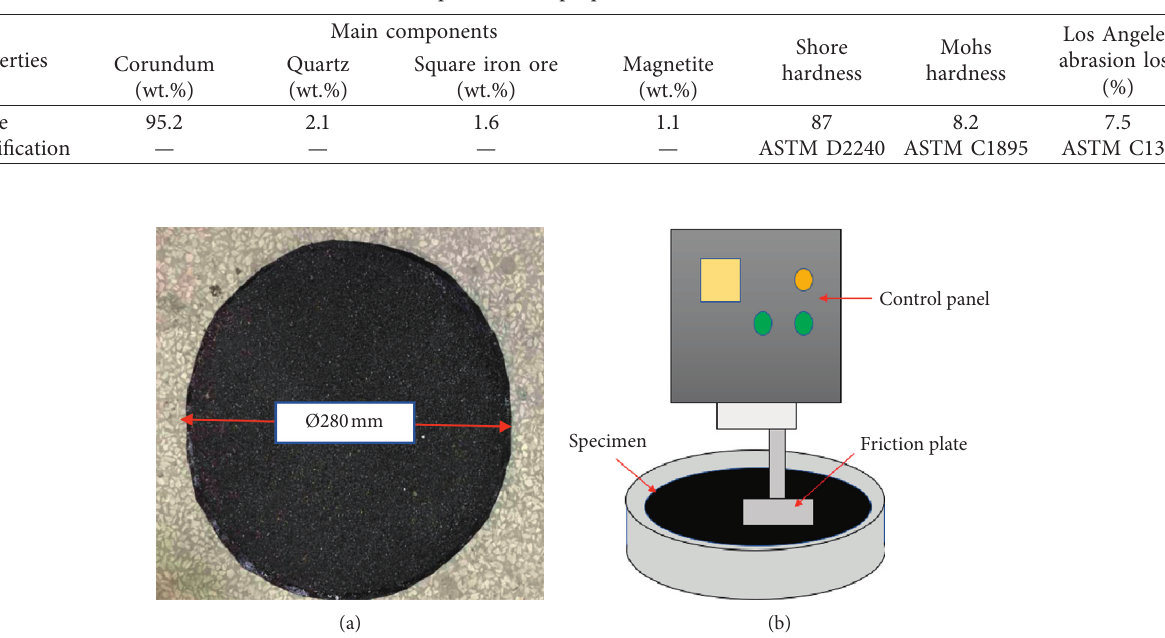
Figure 1: Wet track abrasion: (a) test specimen; (b) test equipment.